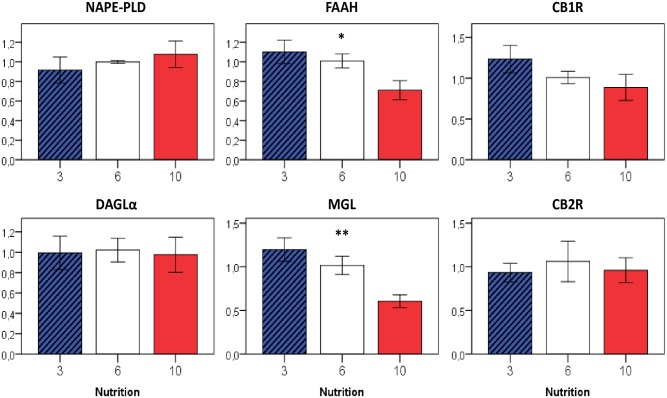
Relative gene expression of eCB-metabolizing enzymes in the liver at P50 in relation to early postnatal nutrition.If not indicated otherwise, displayed significance levels (* p<0.05, ** p<0.01) refer to comparisons between all three nutrition groups (ANOVA). n = 4–6 males per nutrition group.